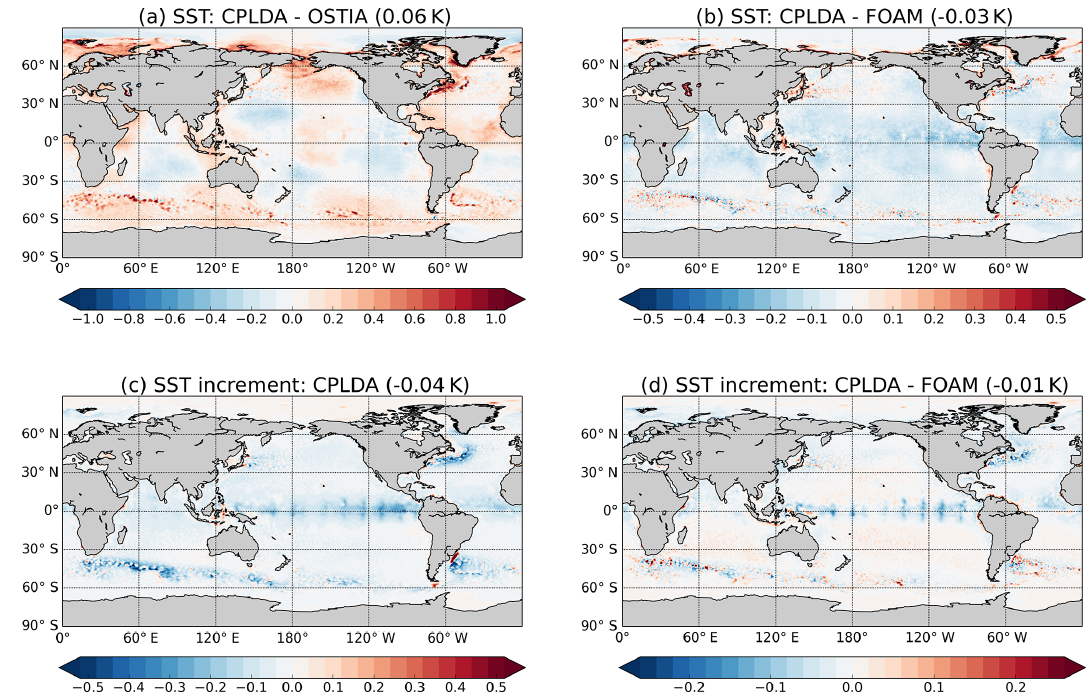
Figure 6. CPLDA SSTs in 2015 compared to (a) OSTIA (0.06K) and (b) FOAM ( − 0 . 03K); (c) mean SST increments in 2015 for CPLDA ( − 0 . 04K); (d) mean SST increments in 2015 for CPLDA compared to FOAM ( − 0 . 01K). Values in parentheses are averages for the global